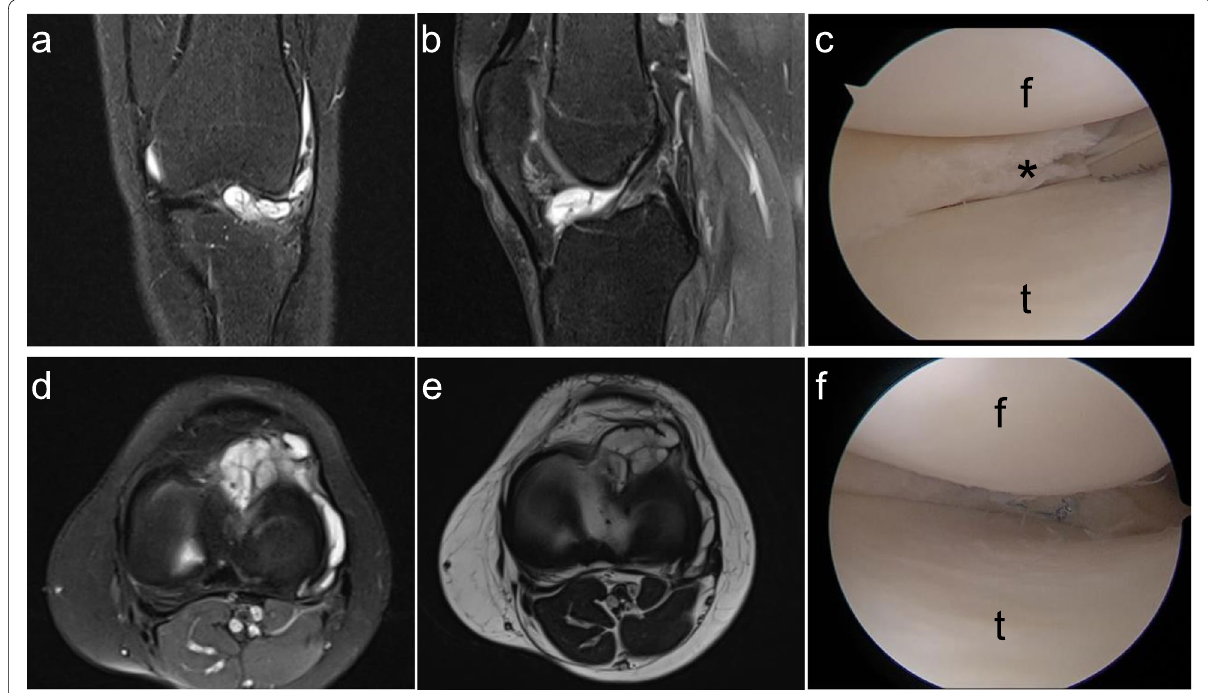
Fig. 1 a and b Coronal and sagittal magnetic resonance image (MRI) of left knee with lateral-sided parameniscal cyst. c arthroscopic view of horizontal meniscal tear (*). d and e Axial view of MRI of the lateral-sided parameniscal cyst. f all-inside meniscal sutures. t: tibia, f: